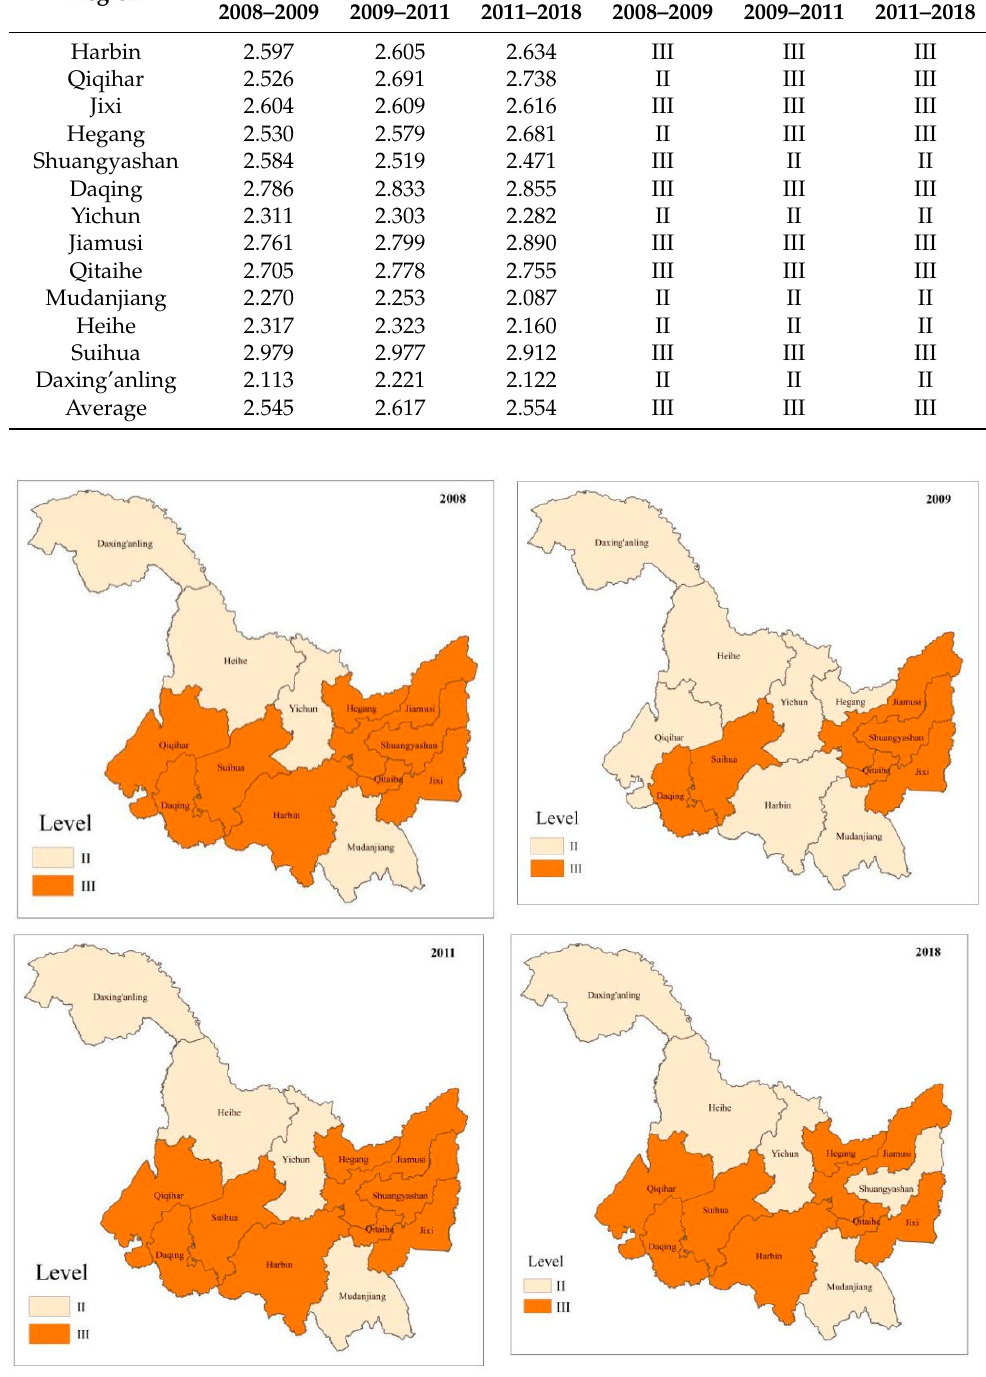
Figure 4. Spatial distribution of AWLRSV in Heilongjiang Province in 2008, 2009, 2011, and 2018.